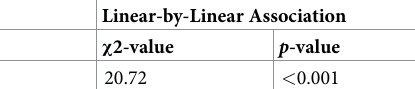
Table 6. Association between number of drugs prescribed and potential drug interactions.